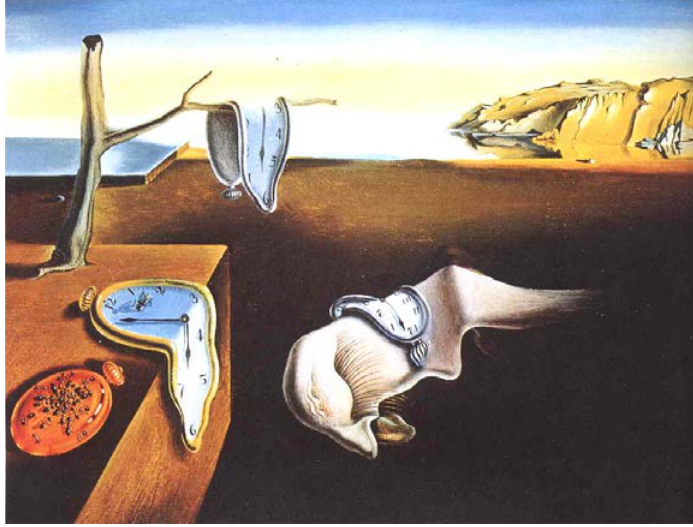
Figure 8 Salvador dali, the persistence of memory,1931, oil on canvas,24×33cm modern art